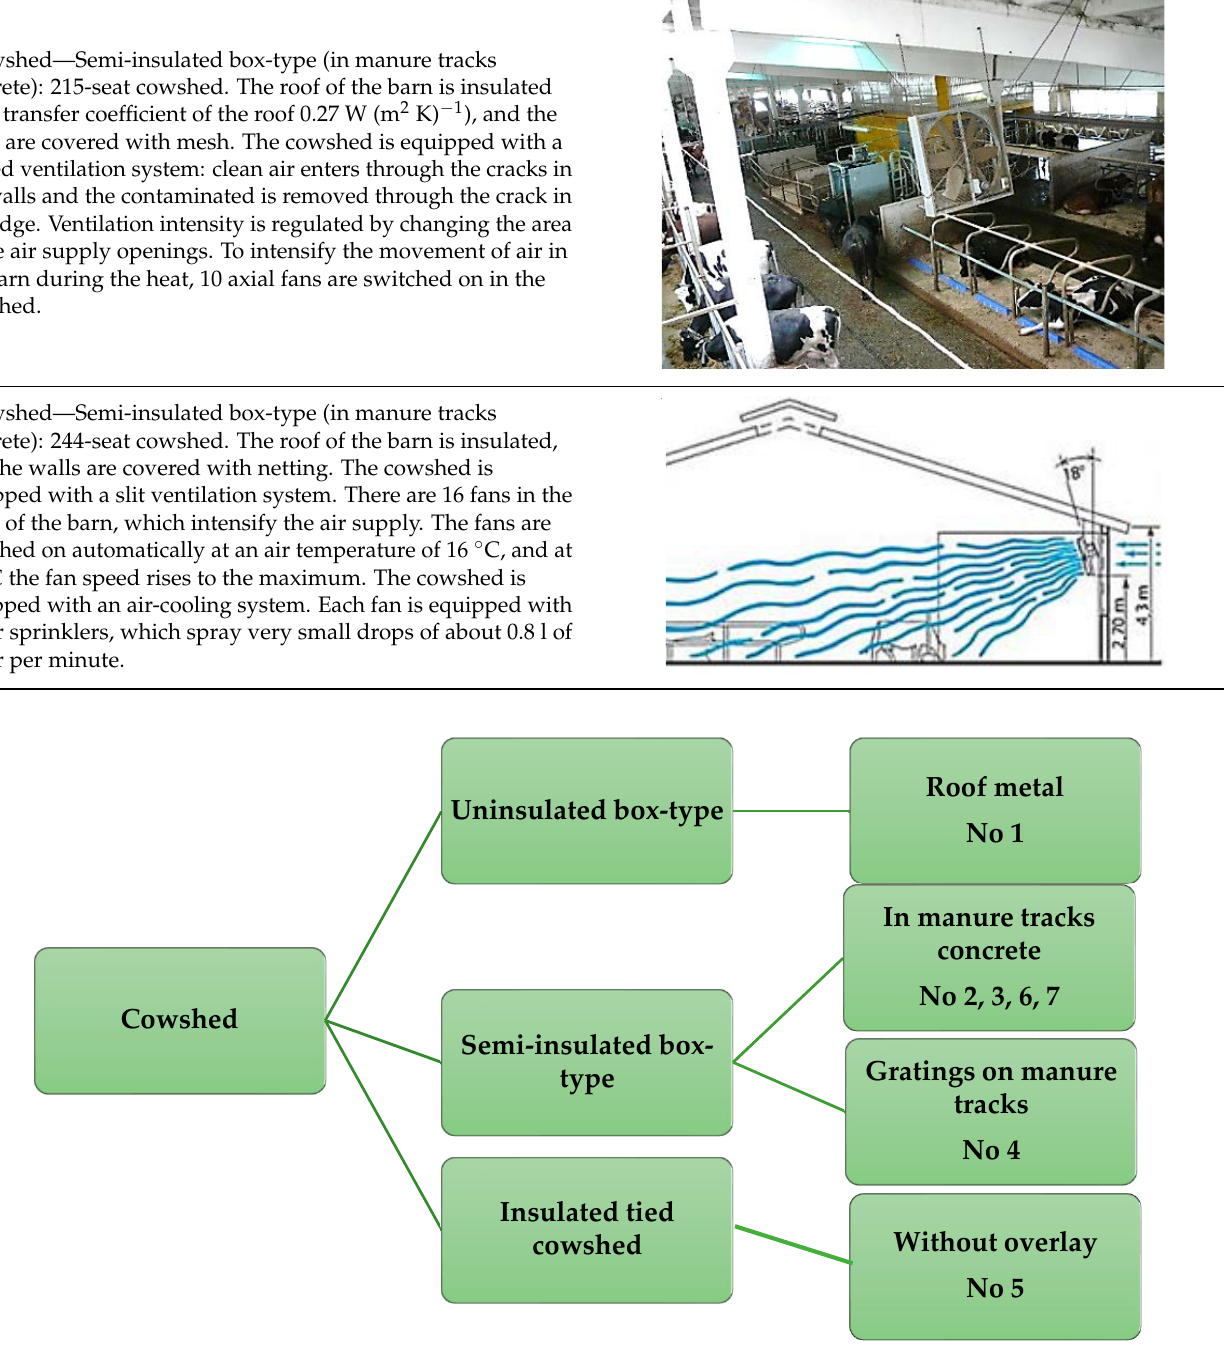
Figure 1. Technological structure of most popular cowsheds in Lithuania . In the selected cowsheds, the cows are kept in the barn all year round. All cowsheds are boxed, with different barn wall and roof constructions, their insulation, manure removal systems, and microclimate formation systems. The cowsheds are equipped with